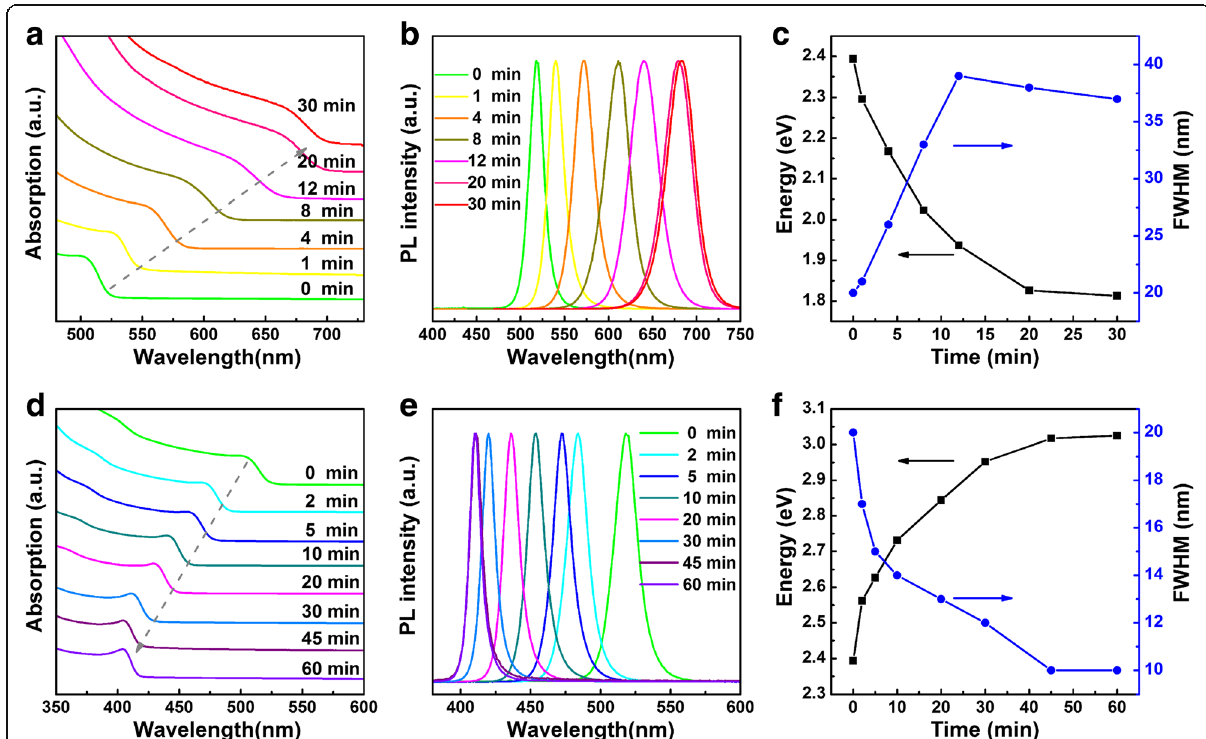
Fig. 2 Ultrasonication time dependent absorption and emission of CsPbBr 3 NCs exchanged with CsX aqueous solutions (1 mol/L). a Absorption spectra, b emission spectra, and c emission peak energy (black square) and emission bandwidth (blue circle) of CsPbBr 3 NCs exchanged in CsI aqueous solution. d Absorption spectra, e emission spectra, and f emission peak energy (black square) and emission bandwidth (blue circle) of CsPbBr 3 NCs exchanged in CsCl aqueous